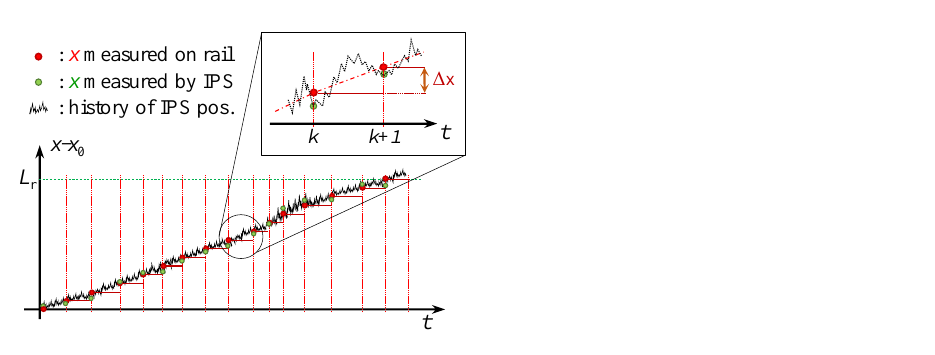
Figure 13. Visualisation of rail and IPS position measurements, where L r is the total length of the rail.